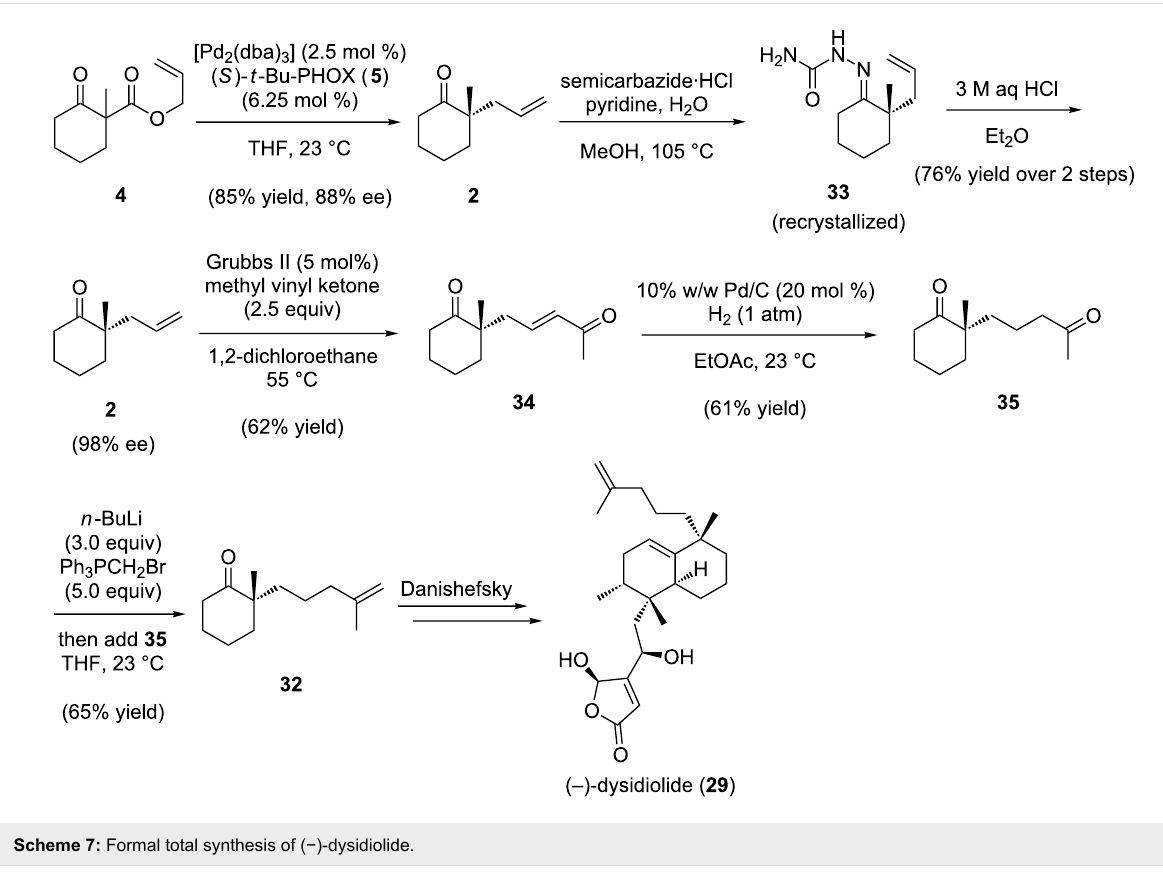
Scheme 7: Formal total synthesis of ( −